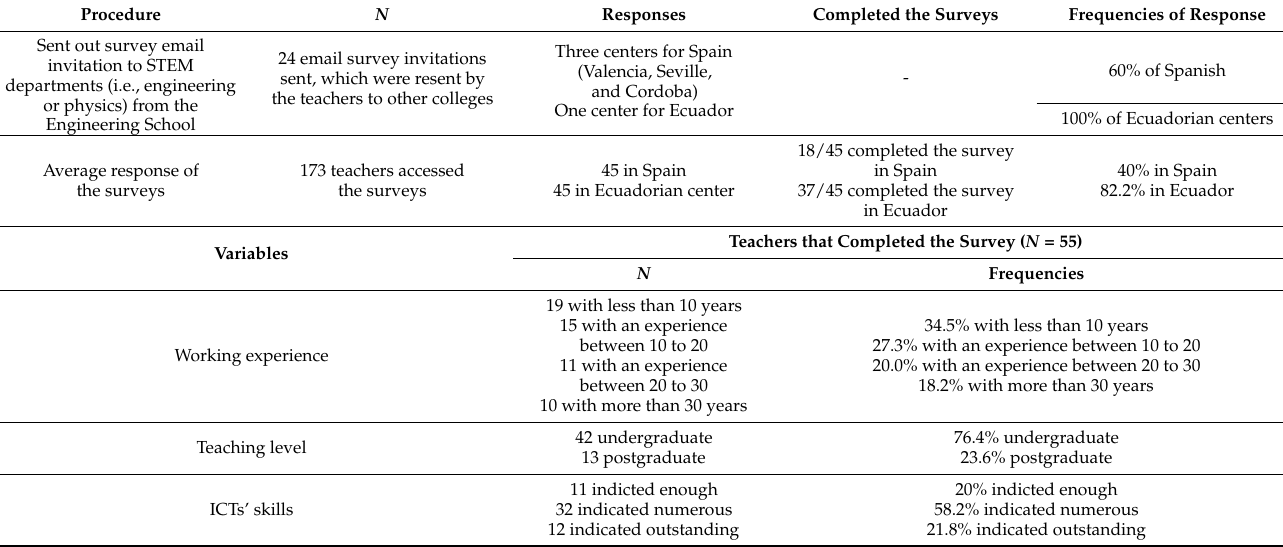
Table 1. Initial data of the procedure and the study